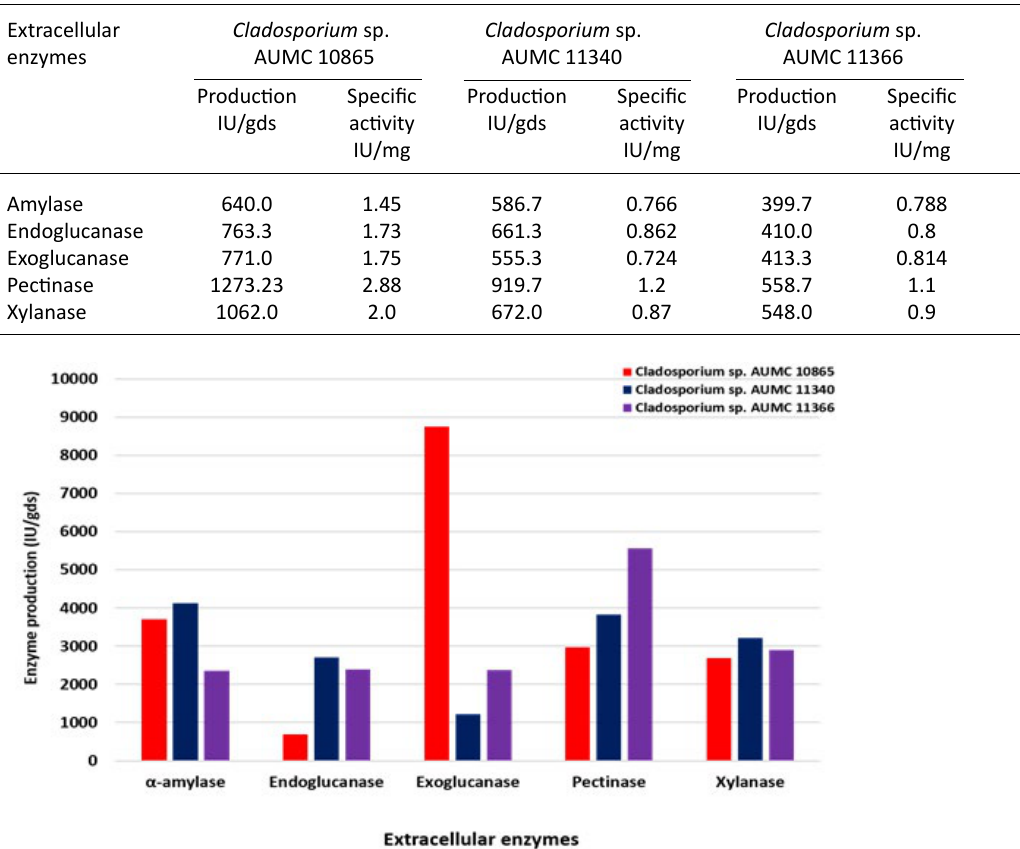
Table 3. Production and specific activity of amylase, endoglucanase, exoglucanase, pectinase and xylanase enzymes produced by Cladosporium isolates AUMC 10865, AUMC 11340 and AUMC 11366 from untreated orange peels in SSF at 10 °C Extracellular Cladosporium sp. Cladosporium sp. Cladosporium sp.